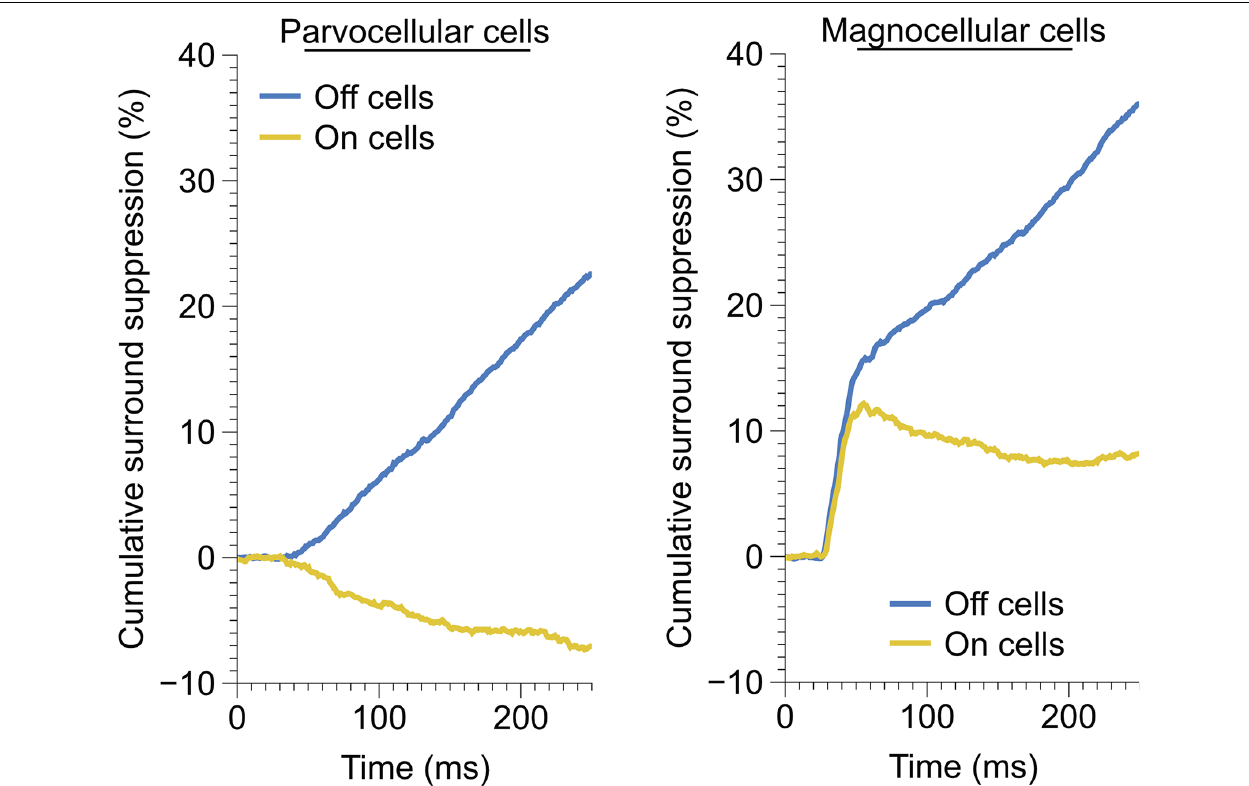
FIGURE 5 | Time-course of monocular surround suppression in the On and Off cells of the parvocellular and magnocellular groupings. Left, time-course of monocular surround suppression in parvocellular cells (Off, n = 20 cells; On, n = 17 cells). Only Off-channel parvocellular cells showed surround suppression, On-channel parvocellular cells show mild surround facilitation. Right, time-course of monocular surround suppression in magnocellular cells (Off, n = 13 cells; On, n = 21 cells). Both channels exhibit fast suppression; late suppression is only present in the Off channel.